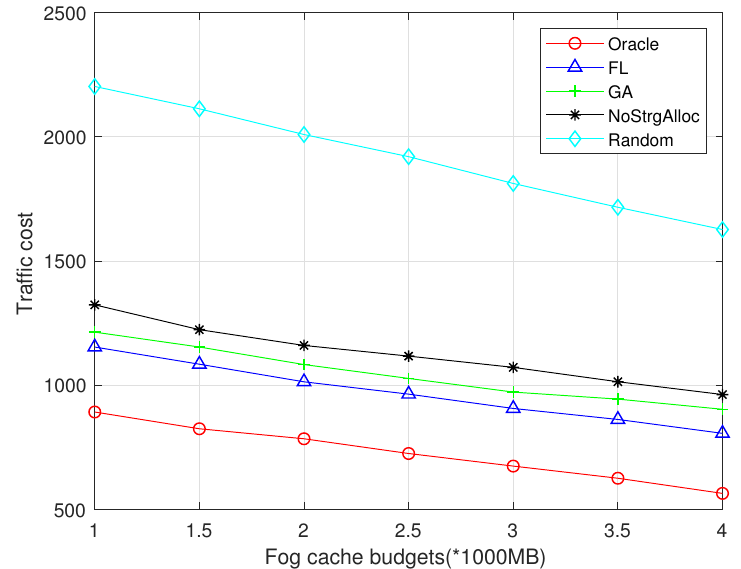
Figure 7. Traffic cost vs Fog cache budgets (MovieLens 100K).